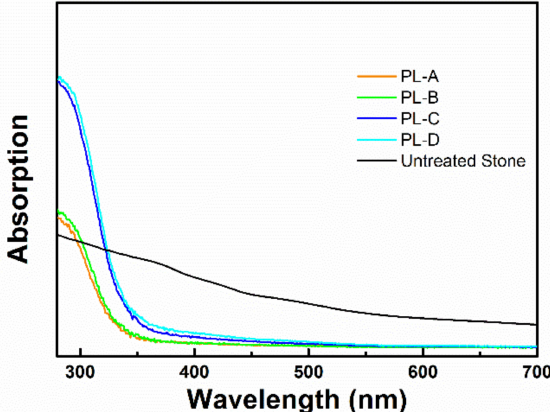
Figure 7. The reflectance spectra in the absorption mode of TiO 2 NRs dispersed the immobilized by spray coating them on Lecce stone substrates. The samples were prepared from a 0.02 M solution of TiO 2 NRs dispersed in n-heptane with an application time of 1 min (PL-A), 1 min 30 s (PL-B), 2 min (PL-C), 2 min 30 s (PL-D),